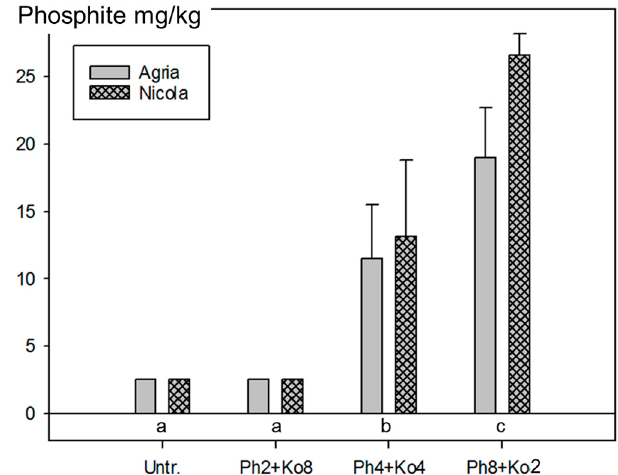
Figure 6. Residues of phosphite (PO 33 − ) in potato tubers from the field experiments in 2013 with two (Ph2 + Ko8), four (Ph4 + Ko4) and eight (Ph8 + Ko2) applications of 1.5 L/ha Phosfik ® (Ph) on the potato foliage and the untreated control (Untr.). Treatments are described in Table S5. Bars represent the mean values from samples of Agria and Nicola at Reckenholz and Tänikon (two samples per treatment) and standard errors of the means. The samples consisted of a mixture of tubers from the four replicates. Since samples from the untreated control (Untr.) and the treatment with two Ph applications (Ph2 + Ko8) were below the limit of detection (LOD = 5 mg/kg), half of the LOD was plotted. Treatments labelled with the same letter are statistically not different (Tukey test p < 0.05).